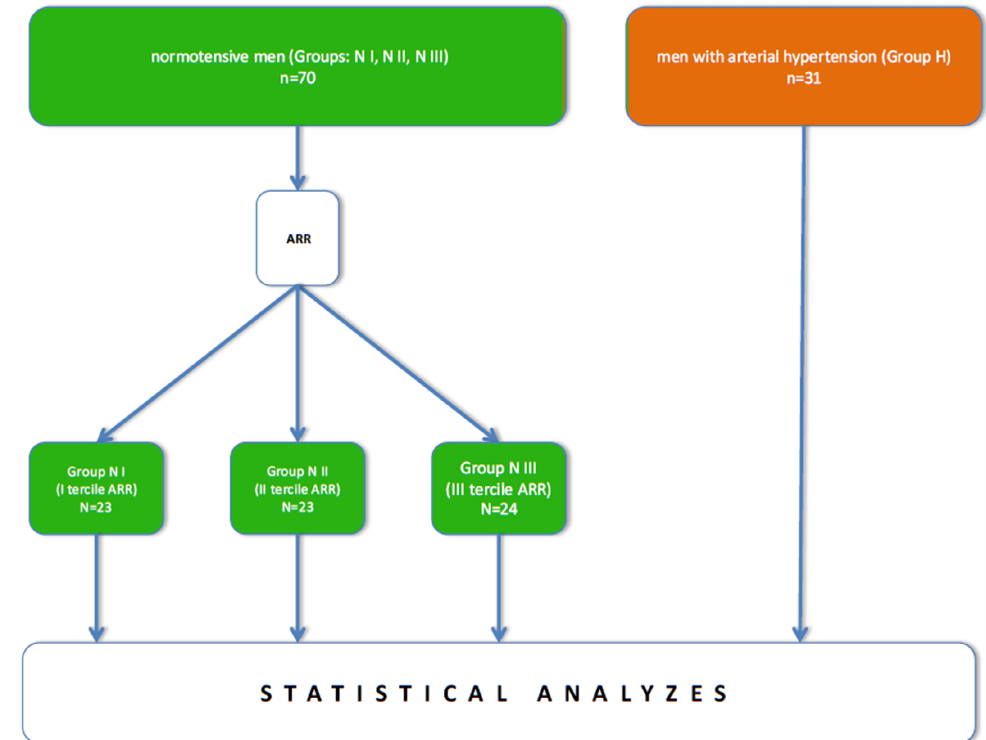
Figure 2. A flow chart—study design—schematic patients’ categorization. ARR—aldosteron to renin ratio.